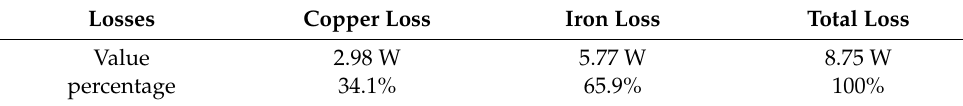
Table 11. Loss percentage of the loss types.